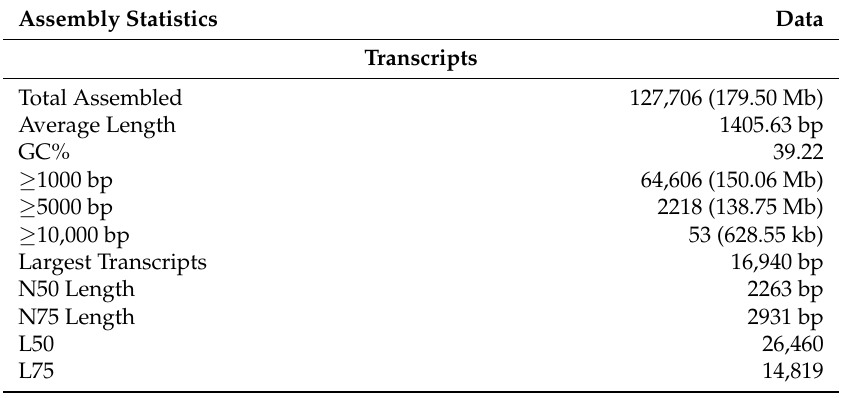
Table 2. Transcriptome assembly and functional annotation of Cyamopsis